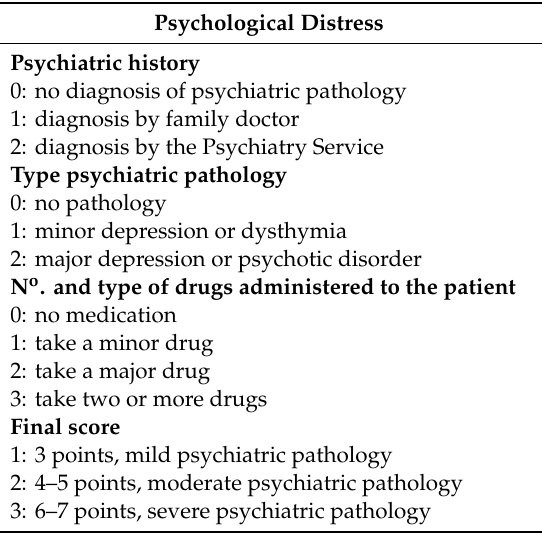
Table 1. Psychological distress